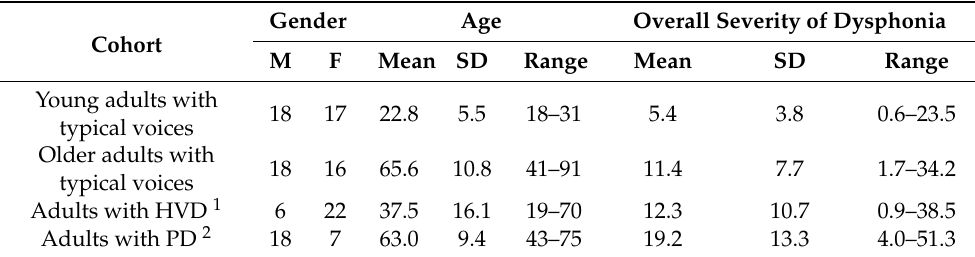
Table 1. Overall demographic information for the 122